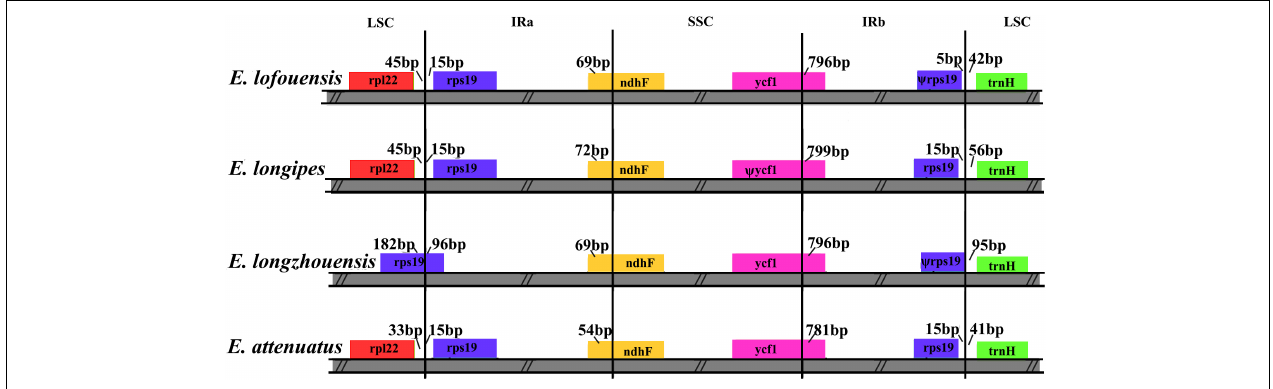
FIGURE 5 | Comparison of the LSC, IR, and SSC junction regions among four Echinacanthus chloroplast genomes. Genes are denoted by colored boxes. (cid:57) shows the pseudogene. The numbers above the gene features indicates the distance between the end of the gene and the borders sites. The slashes indicate the location of the distance. This figure is not to scale.